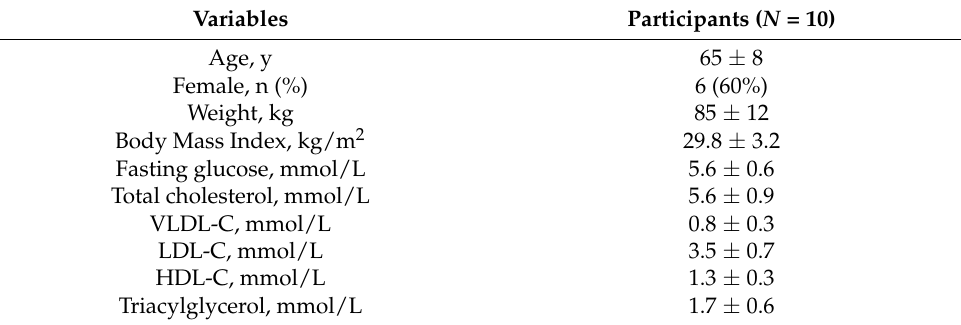
Table 1. Baseline characteristics of the study